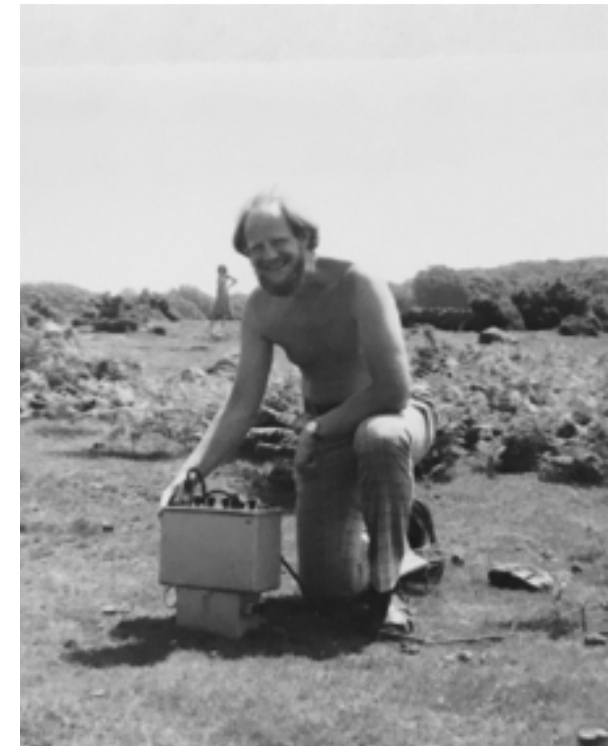
Figure 3. Michael Rycroft checking a magnetometer on a field trip in Devon, on a hot day in July 1977. Photo provided by Prof. Mark